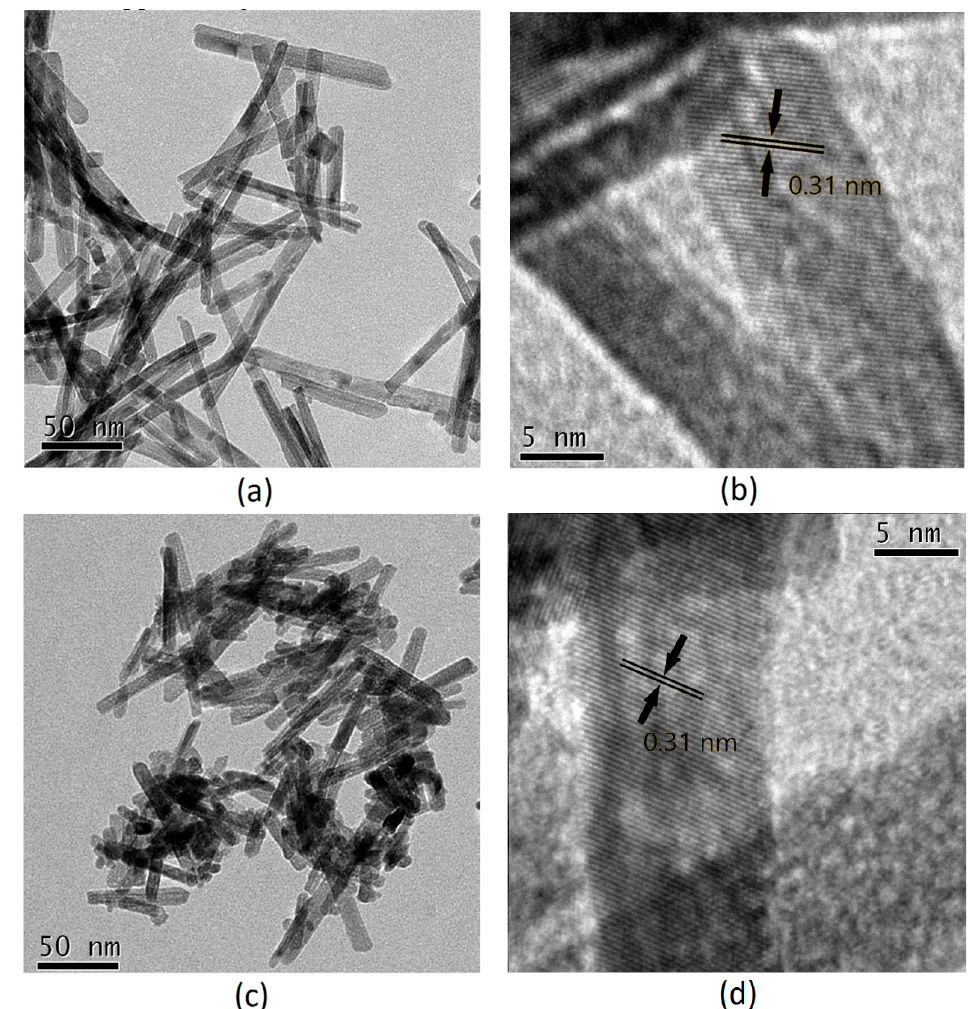
Figure 3. Transmission electron microscopy (TEM) and high-resolution transmission electron microscopy (HRTEM) images of: ( a ) and ( b ) CeO 2 -NR; ( c ) and ( d ) PdO x /CeO 2 -NR.